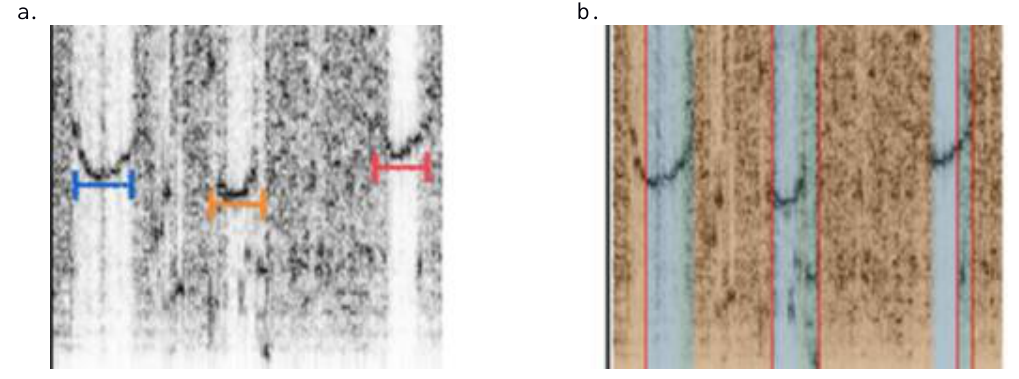
Figure 6 . (a) An example where three patterns similar in shape vary in time and frequency. (b) A segmentation result from our